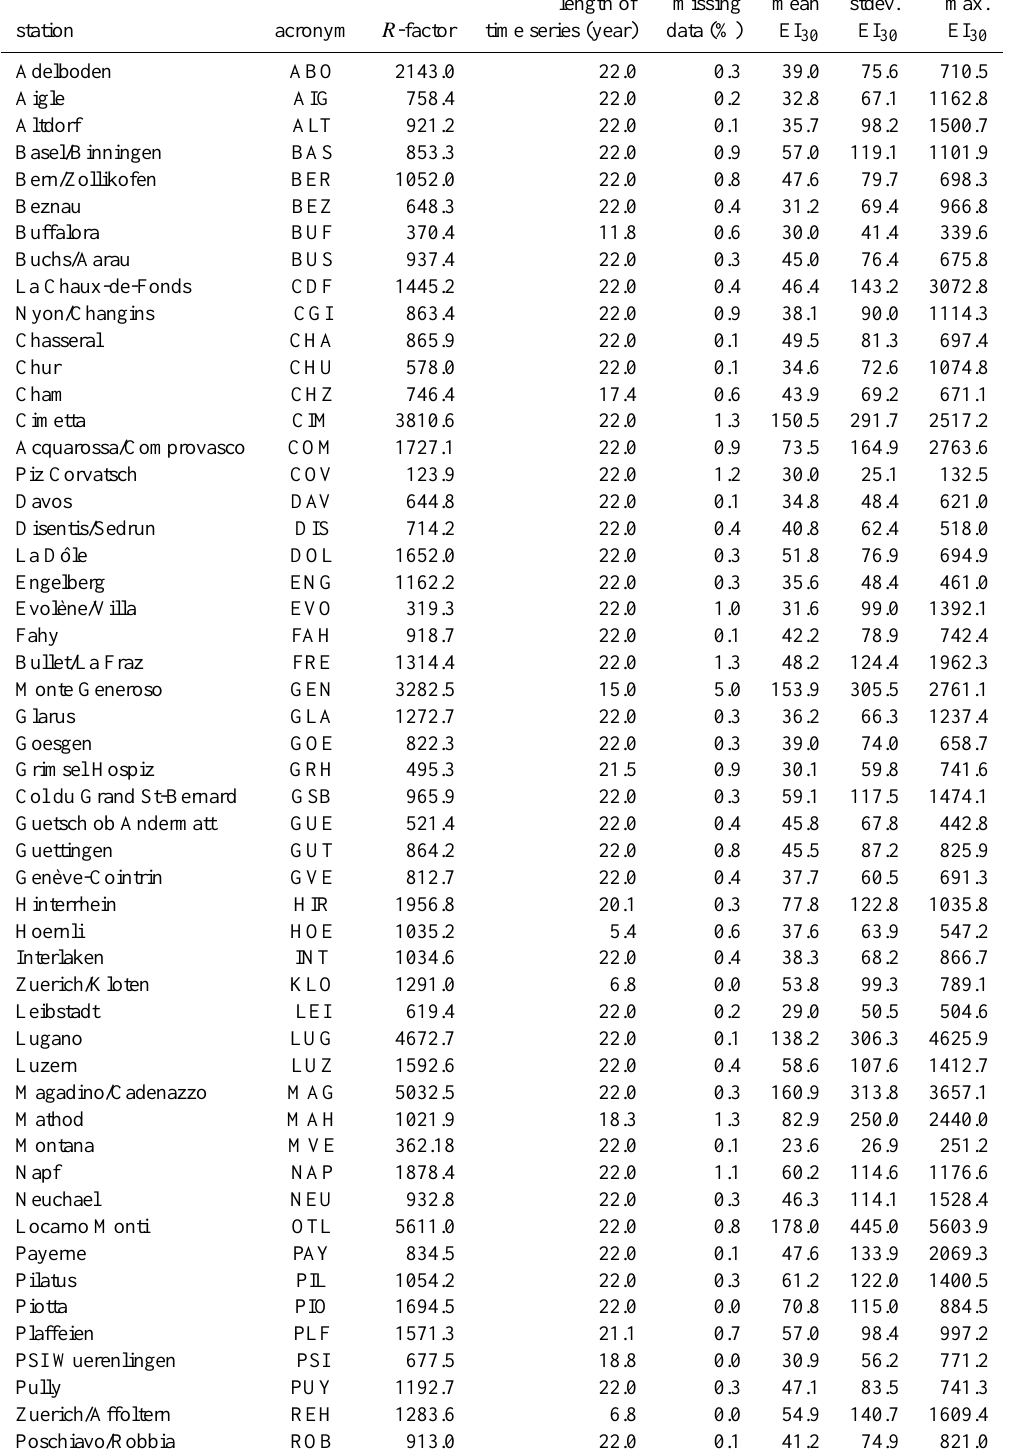
Table 1. Average annual R -factor (MJmmha − 1 h − 1 yr − 1 ) of the (Revised) Universal Soil Loss Equation and descriptive statistics of the event’s rainfall erosivity (MJmmha − 1 h − 1 ) for single